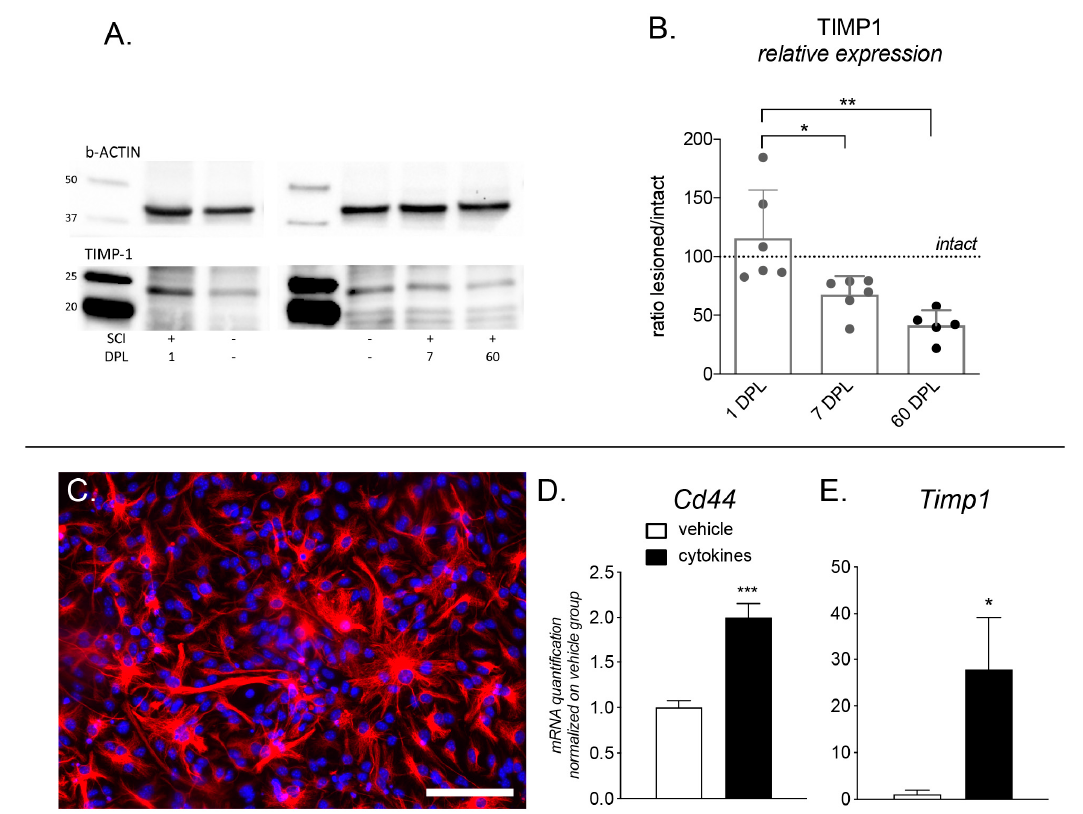
Figure 6. Timp1 protein quantification in the spinal cord and expression of Cd44 and Timp1 in primary astrocyte cultures: ( A ) Two representative gels are shown in the figure. Upper panel shows b-Actin (43 kDa), used as house-keeping protein, lower panel shows Timp1 (23 kDa) in each analyzed group (intact animals: SCI-; lesioned: SCI+ at 1 DPL, 7 DPL and 60 DPL); ( B ) Graph shows relative Timp1 expression calculated as signals as measured by densitometry, indicated by relative intensity (lesioned versus controls). Statistical analysis: one-way ANOVA and Tukey post-hoc test, * p < 0.05; ** p < 0.001; ( C ) Micrograph illustrates pure astrocyte cultures stained for GFAP marker; ( D , E ) Graphs show mRNA expression level of Cd44 ( D ) and Timp1 isoform b ( E ) in cultures exposed to vehicle or cytokine mix for 48 h. Statistical analysis. Student’s t -test. Asterisk represents difference between vehicle- and cytokine- treated groups (* p > 0.05).